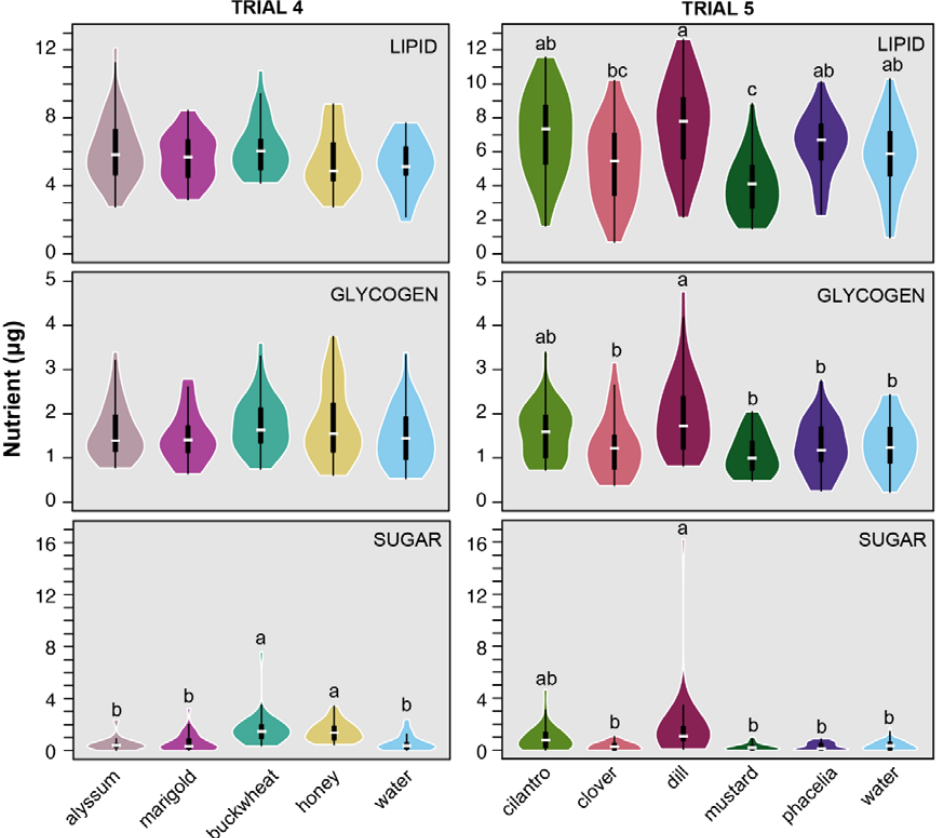
Figure 2. Kernel density plots of nutrient levels of female Trissolcus japonicus fed with flower treatments, honey, or water for 48 h inside vials in the lab. Internal boxplots show the median, interquartile range, maximum, and minimum. Treatments with different letters are significantly different based on Tukey post-hoc tests.